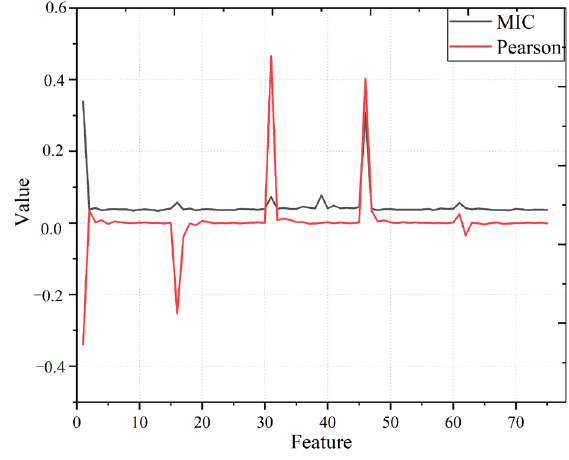
Figure 6. MIC and Pearson plots.